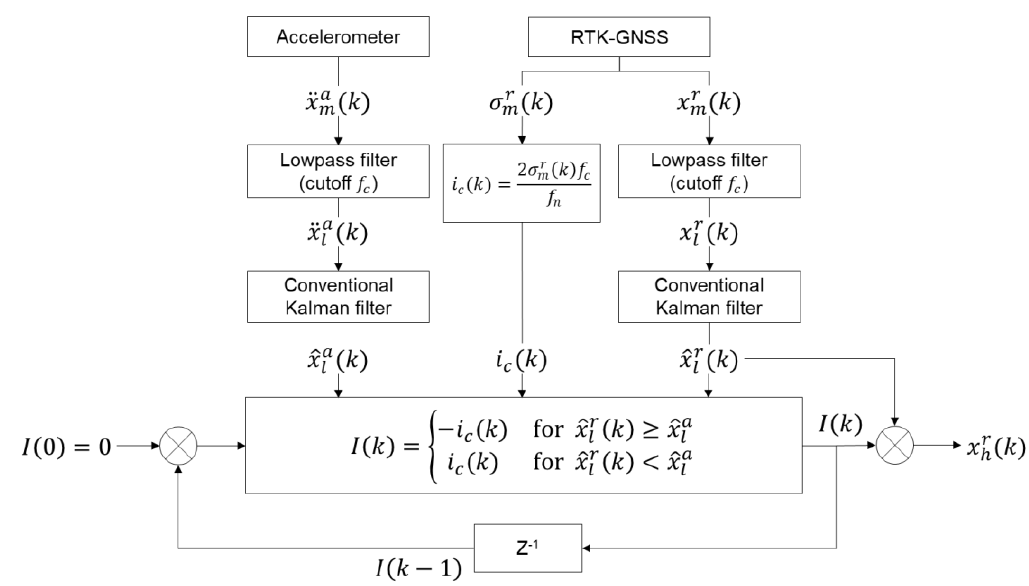
Figure 3. Block diagram of modified heuristic drift reduction. The MHDR mitigates the low-frequency error contained in the RTK-GNSS displacement signal using acceleration.